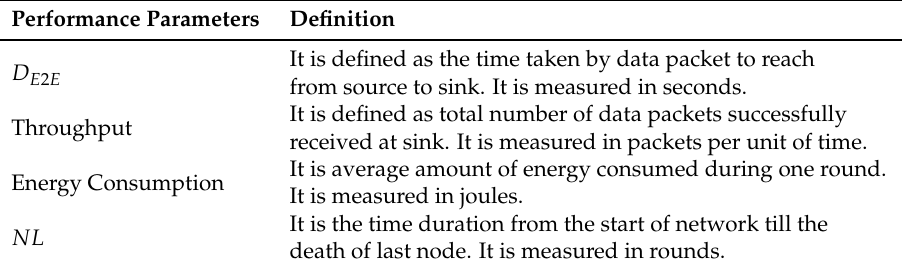
Table 4. Network performance parameters.